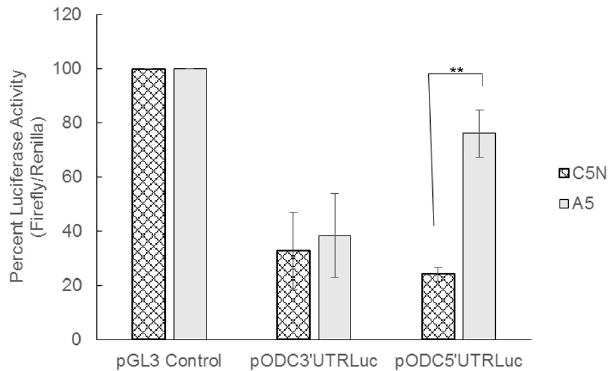
Figure 2. Insertion of the ODC UTRs in the pGL3 control vector causes a decrease in luciferase activity. C5N and A5 cells were transfected with either the pGL3 control vector, pODC3 ′ UTRLuc, or pODC5 ′ UTRLuc. A plasmid containing the renilla luciferase gene was co-transfected into these cells and used as a transfection efficiency control. Luciferase activity was measured 48 h after transfection. Firefly luciferase activity was normalized to renilla luciferase for each sample. The luciferase activity of pGL3 control was set to 100% and the samples from cells transfected with pODC3 ′ UTRLuc and pODC5 ′ UTRLuc are shown as a percentage of the pGL3 control luciferase activity. Values are means ± S.E. ( n = 9). The difference in luciferase activity between the pGL3 control and both pODC3 ′ UTRLuc and pODC5 ′ UTRLuc were statistically significant for each cell line. ** p < 0.005.